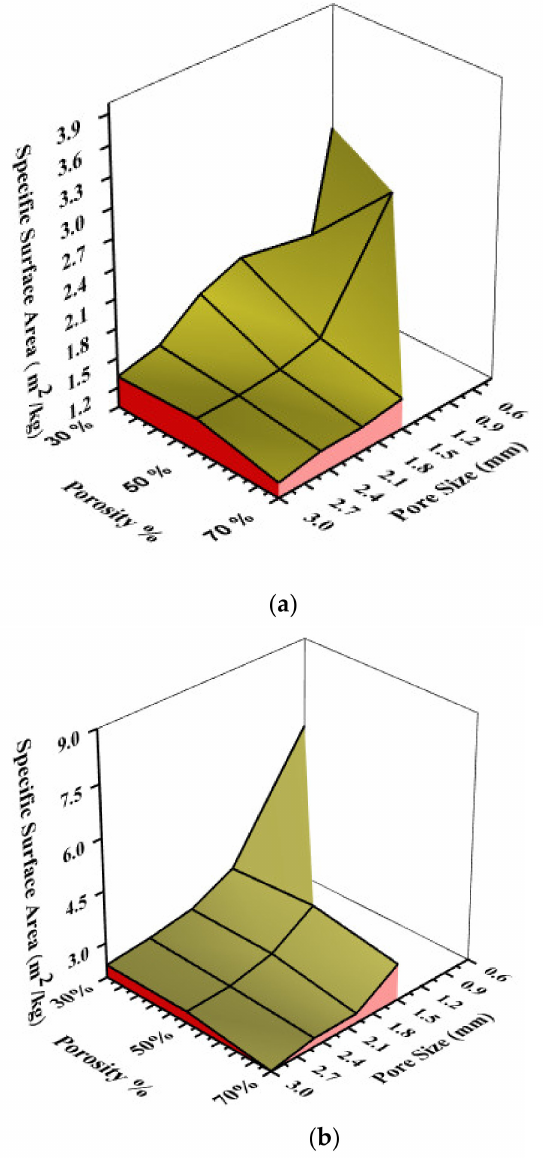
Figure 6. Specific surface area with respect to the pore size and porosity: ( a ) cubic structures; ( b ) hexagonal closed packed